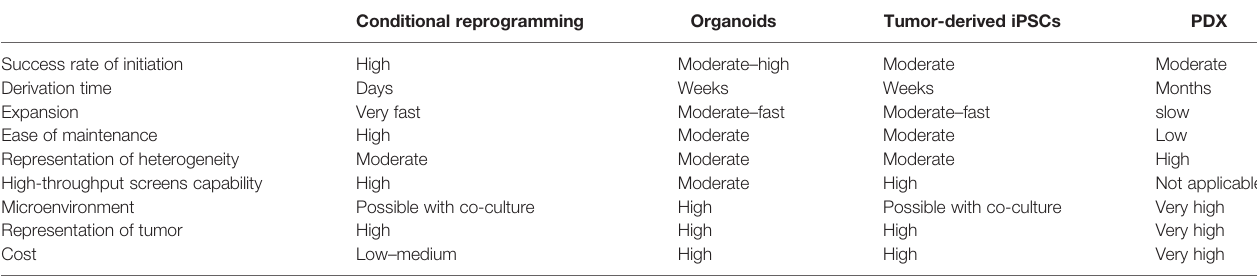
TABLE 1 | Comparison of patient-derived cancer models CR, organoids, iPSCs, and PDX. Conditional